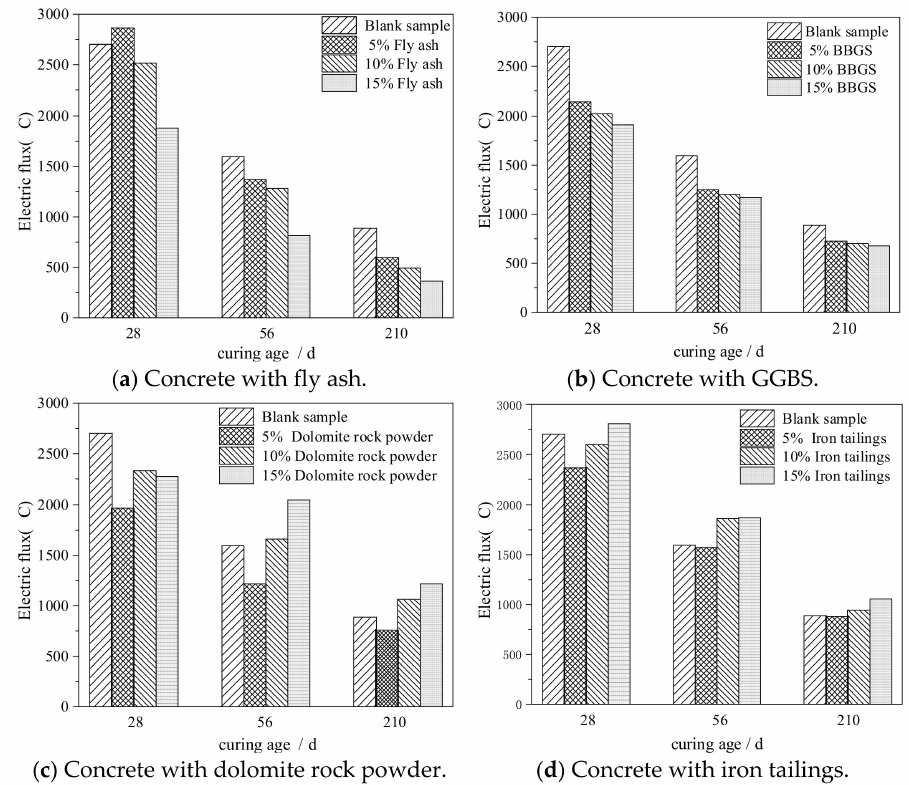
Figure 4. Electric flux of all